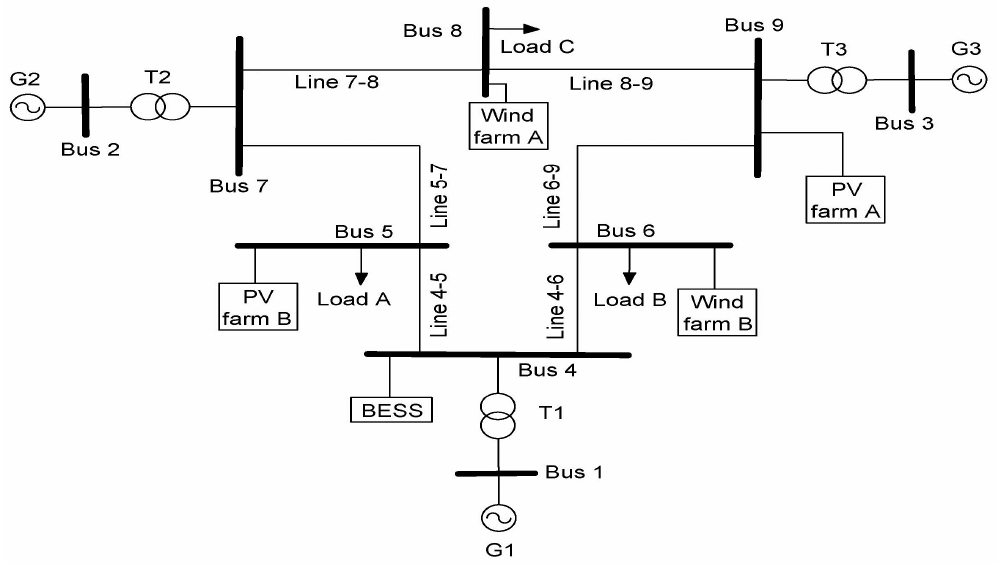
Figure 6. IEEE 9 bus standard test network with installed BESS and RES. G,